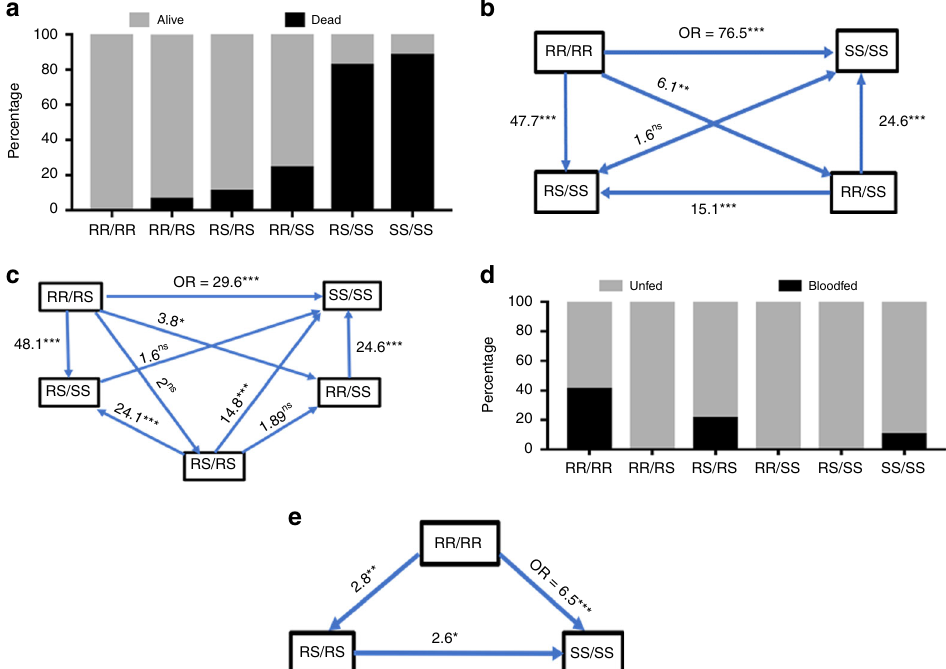
Fig. 6 CYP6P9b combines with CYP6P9a to further reduce bed nets ’ ef fi cacy. a Distribution of the combined genotypes of both CYP6P9a and CYP6P9b showing that genotypes at both genotypes combined to additively increase the ability to survive after exposure to PermaNet 2.0. b Ability to survive exposure to PermaNet 2.0 (Odds ratio) of the double homozygote-resistant (RR/RR) genotypes of CYP6P9a and CYP6P9b compared to other genotypes supporting the additive resistance effect of both genes. Signi fi cance is shown by * P < 0.05, ** P < 0.01, *** P < 0.001, as estimated using Fisher ’ s exact test. c Ability to survive exposure to PermaNet 2.0 (odds ratio) of the combined homozygote resistant and heterozygote (RR/RS) genotypes of CYP6P9a and CYP6P9b compared to other genotypes. d Distribution of the combined genotypes of both CYP6P9a and CYP6P9b after exposure to PermaNet 3.0 revealing an additive effect of both genes in increasing the ability to blood feed. e Comparison of blood feeding ability of combined genotypes of CYP6P9a and CYP6P9b showing a signi fi cantly higher ability (odds ratio) to blood feed for mosquitoes that double homozygote resistant (RR/RR). Source data